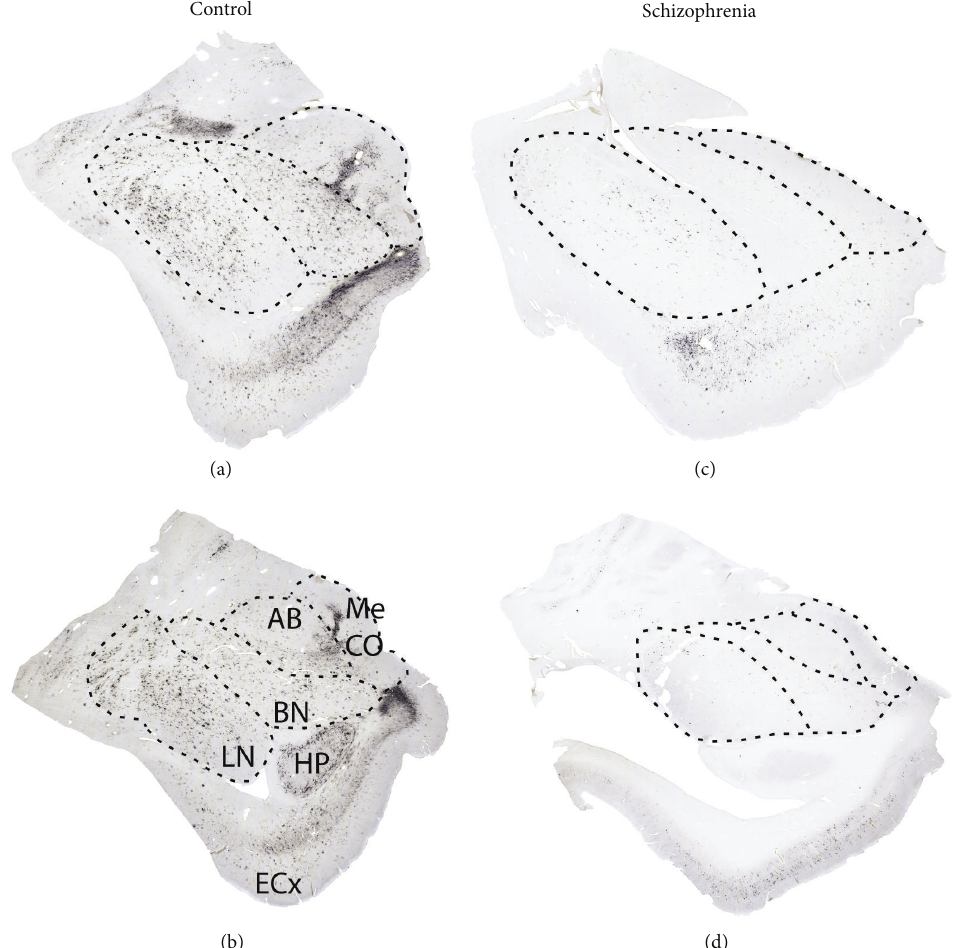
Figure 2: Decreased CS-6 in the amygdala of subjects with schizophrenia. In the amygdala of control subjects, CS-6(3B3)-labeled PNNs and glial cell clusters are distributed in the lateral (LN), basal (BN), accessory basal (AB), and corticomedial (CO-Me) nuclei (a, b). In subjects with schizophrenia, marked decreases of PNNs and glia cell clusters immunolabeled for CS-6(3B3) were observed in the amygdala of (c, d) [55]. ECx: entorhinal cortex. HP: